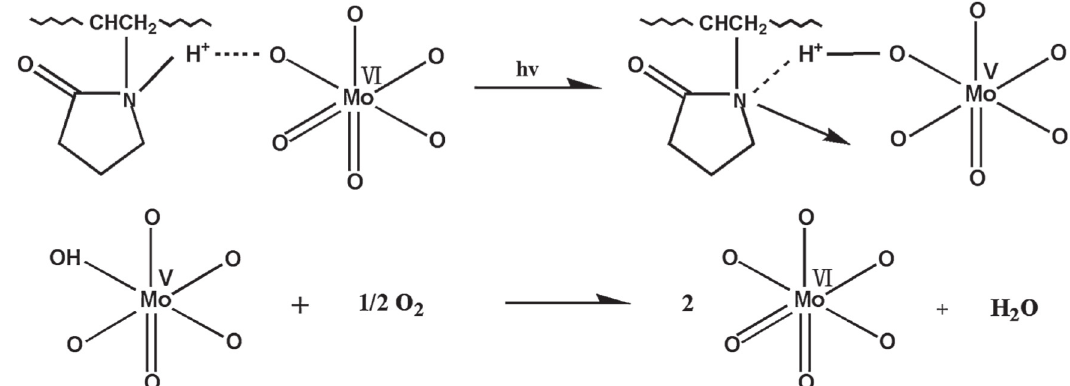
Figure 6. The environment of the photo-reduced site and the process of the photo-reduced reaction. This image was published in Applied Surface Science, 316, Wang X.; Dong Q.; Meng Q.; Yang J-Y.; Feng W.; Han X. Visible-light photochromic nanocomposites